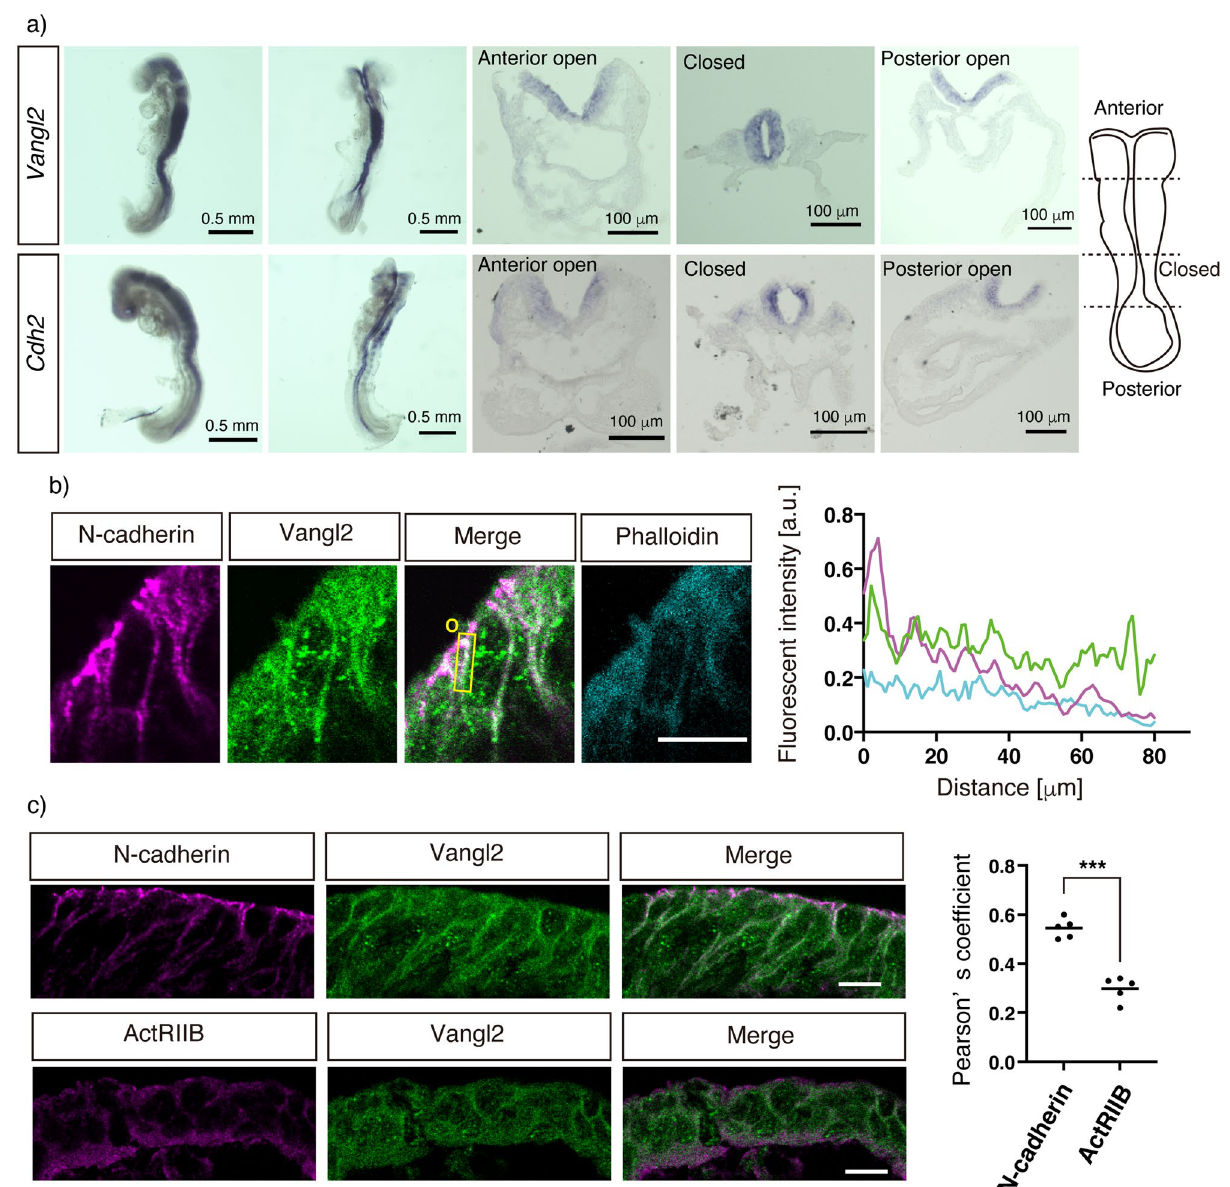
Figure 2. Vangl2 and N-cadherin expression in mouse embryos. ( a ) Whole mount in situ hybridization with antisense probes for Vangl2 and Cdh2 in mouse embryos at E8.5 (lateral view, left panel; dorsal view, second left panel). The transverse images of the embryos sectioned at the indicated levels with the dashed lines (cartoon on the right) are also presented (middle panels; the anterior neural plate, second right panels; closed neural tube, right panels; posterior neural plate). Vangl2 and Cdh2 are predominantly expressed in the neural plate and neural tube. ( b ) Coronal section of the mouse neural plate using anti-N-cadherin (magenta), anti-Vangl2 (green), and phalloidin (cyan). The plot profile of each fluorescent signal intensity in the depicted rectangle (yellow box) is shown on the right with the respective color. The line graphs indicate the partial co-localization of Vangl2 and N-cadherin. O; origin. ( c ) Double immunofluorescence analysis of Vangl2 and N-cadherin and that of Vangl2 and activin receptor type IIB (ActRIIB). The Pearson’s coefficients of their co-localization measured using the software Coloc 2 are presented as dot graphs. The coefficient of Vangl2/N-cadherin is significantly higher than that of Vangl2/ActRIIB. Significant differences between groups were calculated using the Student’s t -test (*** P < 0.0001). Scale bars: 0.5 mm (whole mount) and 100 μm (sectioned) in a, 10 μm in b and